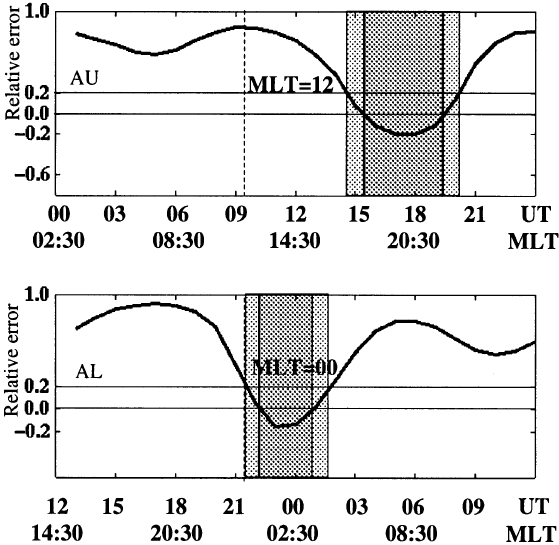
Fig. 4. UT dependence of the average relative errors between the global and local A ” ( upper panel ) and A ‚ ( lower panel ). The UT- periods when the error is below 0.2 and below 0 (i.e., the local chain sees stronger activity than the global one) are marked with lighter and darker shadings ,